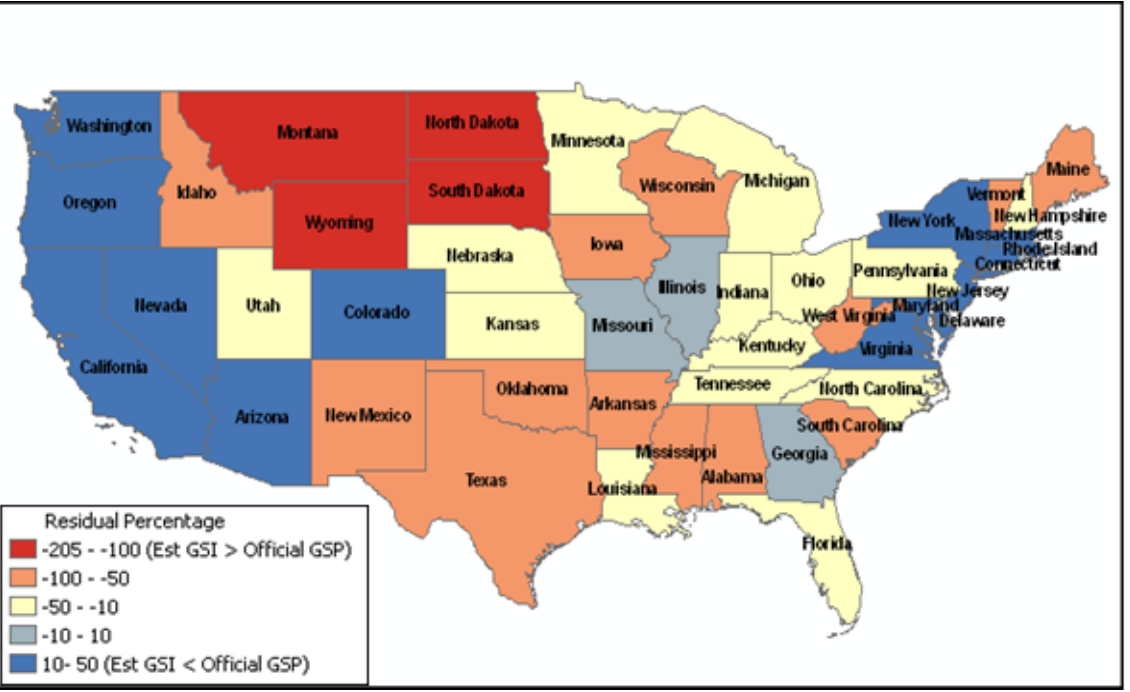
Table 6. Official GSP